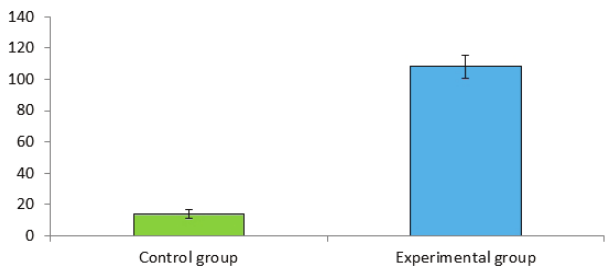
FIGURE 1 – Comparison between the control and experimental groups in relation to the total number of megakaryocytes. The main bars are the mean values for the groups and the error bars represent their standard deviations.